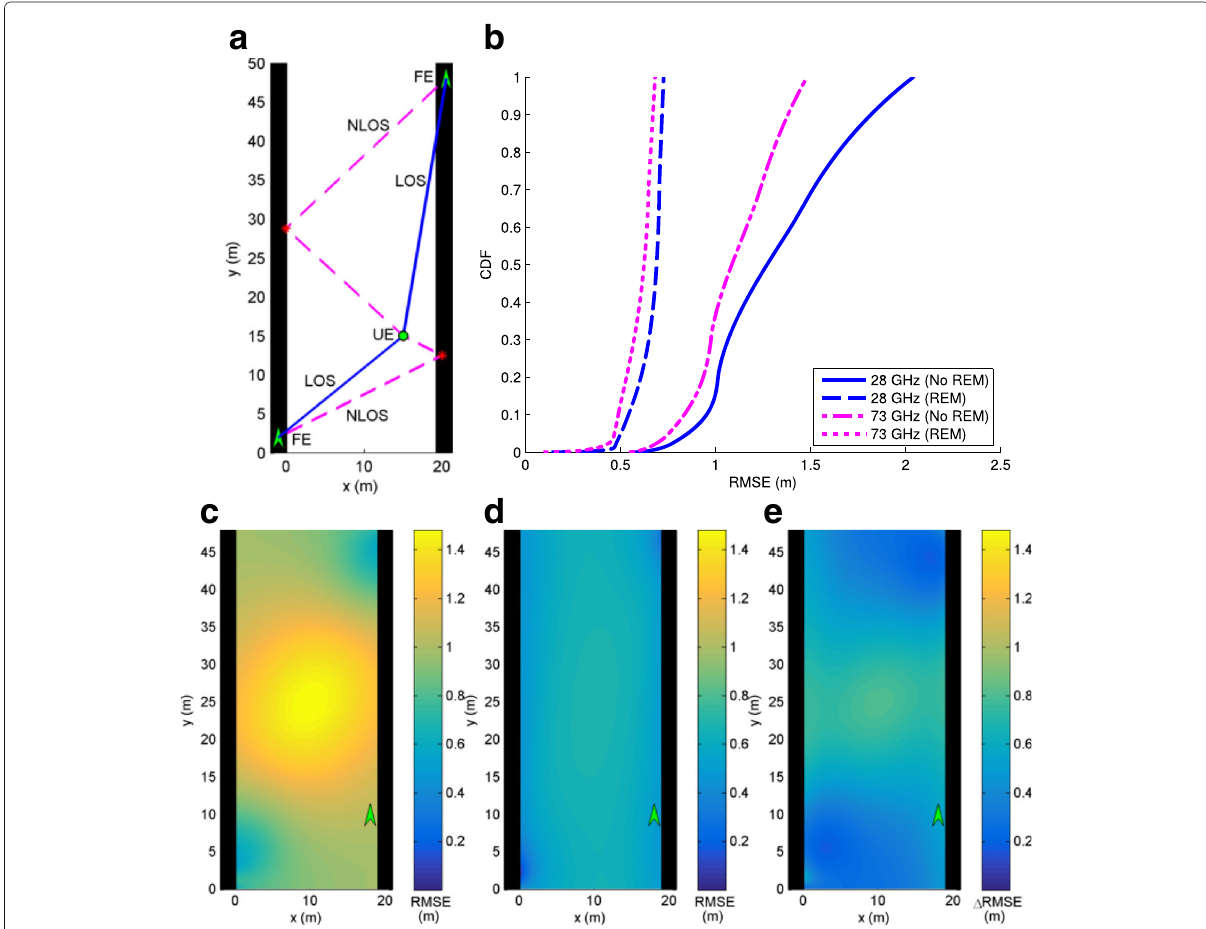
Fig. 7 a Urban canyon with two FEs, two LOS paths, and two NLOS paths. b CDF of RMSE. c RMSE at 73 GHz without REM. d RMSE at 73 GHz with REM. e Improvement in RMSE with REM at 73